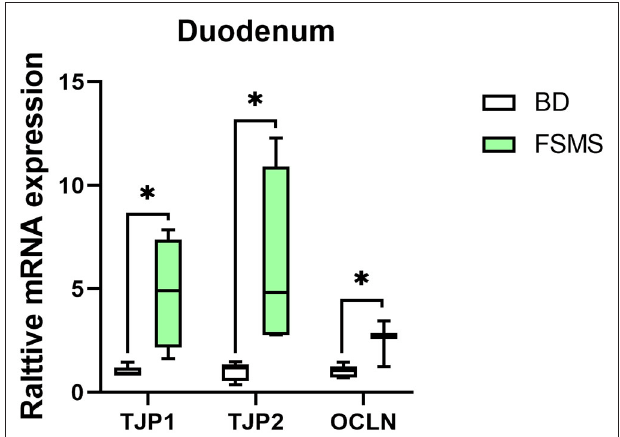
FIGURE 1 | Influence of FSMS addition on the tight junction transmembrane protein, tight junction protein 1 (TJP1), tight junction protein 2 (TJP2), and